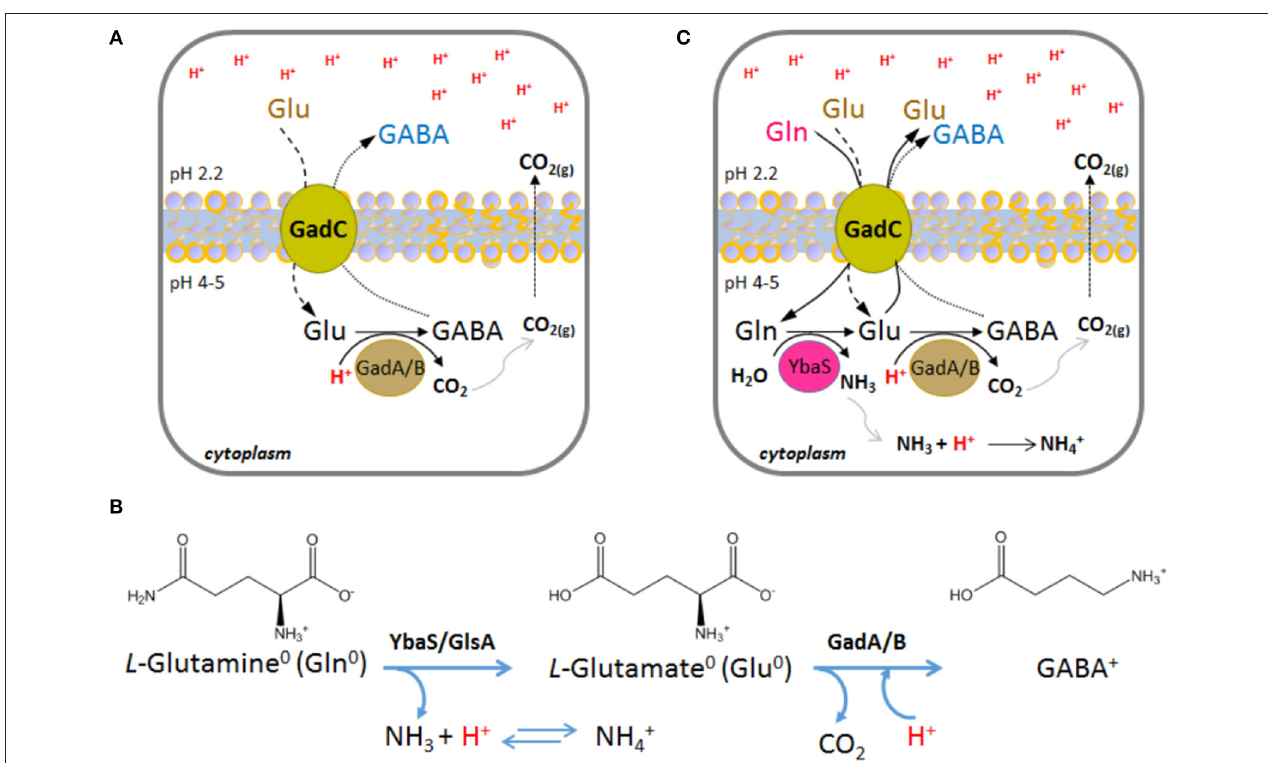
FIGURE 1 | Schematic representation of the enzymatic reactions and transport activity in the AR2 and AR2_Q systems in Escherichia coli. (A) A typical situation where the AR2 comes into action is when the drop of the extracellular pH to below 2.5 leads, as a consequence, to the decrease of the intracellular pH to below 5. This activates the GadC-mediated import of Glu 0 (if available extracellularly) and the export of GABA + , the latter generated by the intracellular proton-consuming activity of GadA/B. (B) Chemical structures and net charge of the species imported and exported by GadC, according to (Ma et al., 2013; Tsai et al., 2013). The reactions and the enzymes involved are shown. (C) A situation where the AR2_Q can be operative is when the extracellular pH drops below 2.5 and, as a consequence, the intracellular pH decreases to below 5. This activates the GadC-mediated import of Gln 0 (when available extracellularly) and the export of Glu 0 (arising from Gln deamination) or GABA + (arising from Glu decarboxylation). In AR2_Q, protons are taken up during ammonium ion formation and during GABA synthesis. According to previous reports ( Ma et al., 2013; Tsai et al., 2013), GadC can export either Glu 0 or GABA + , depending on the cellular need to buffer the cytosol and effectively consume